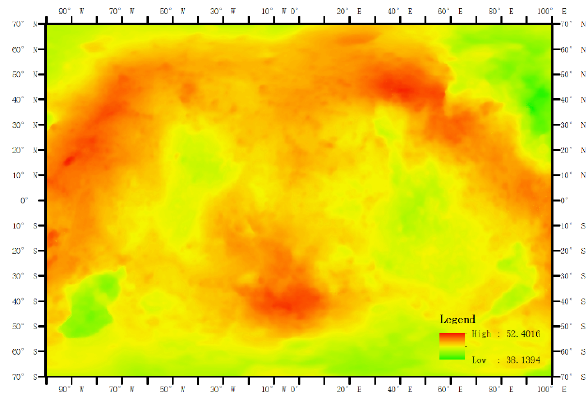
Figure 9. DEM between latitudes of 70 ° N and 70 ° S